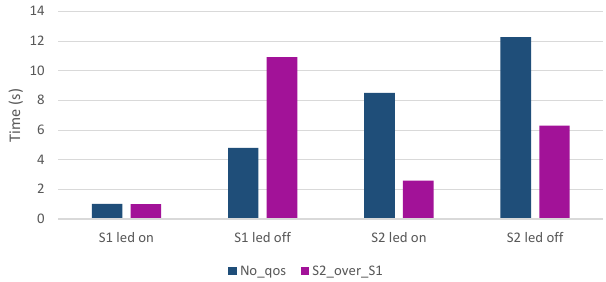
Figure 27. Priority traffic